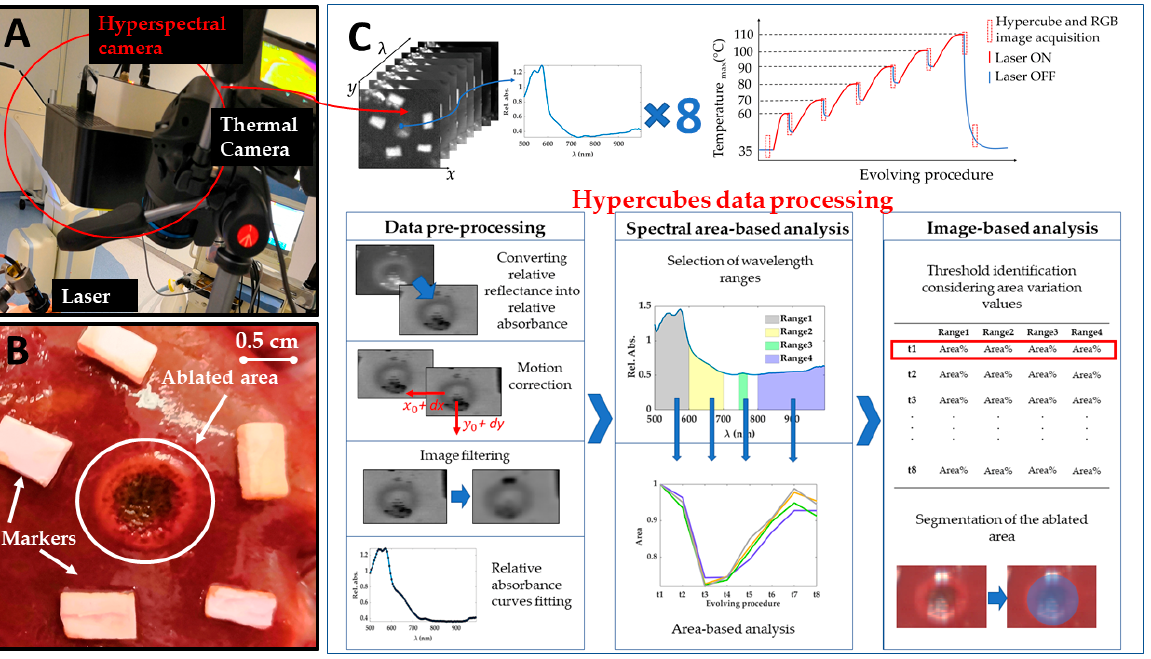
Figure 1. ( A ) Experimental setup including laser system delivering light at 808 nm, thermal camera acquiring temperature values during the overall procedure, and hyperspectral camera. ( B ) A detail of one target area (Test 1) after the treatment. Two different regions are visible for the ablated area: (i) a darker center and (ii) a brighter ring zone highlighting boundaries of the area of interest. ( C ) A scheme showing the acquired hypercubes, the workflow of the experiments, and the data processing steps for the hyperspectral data.